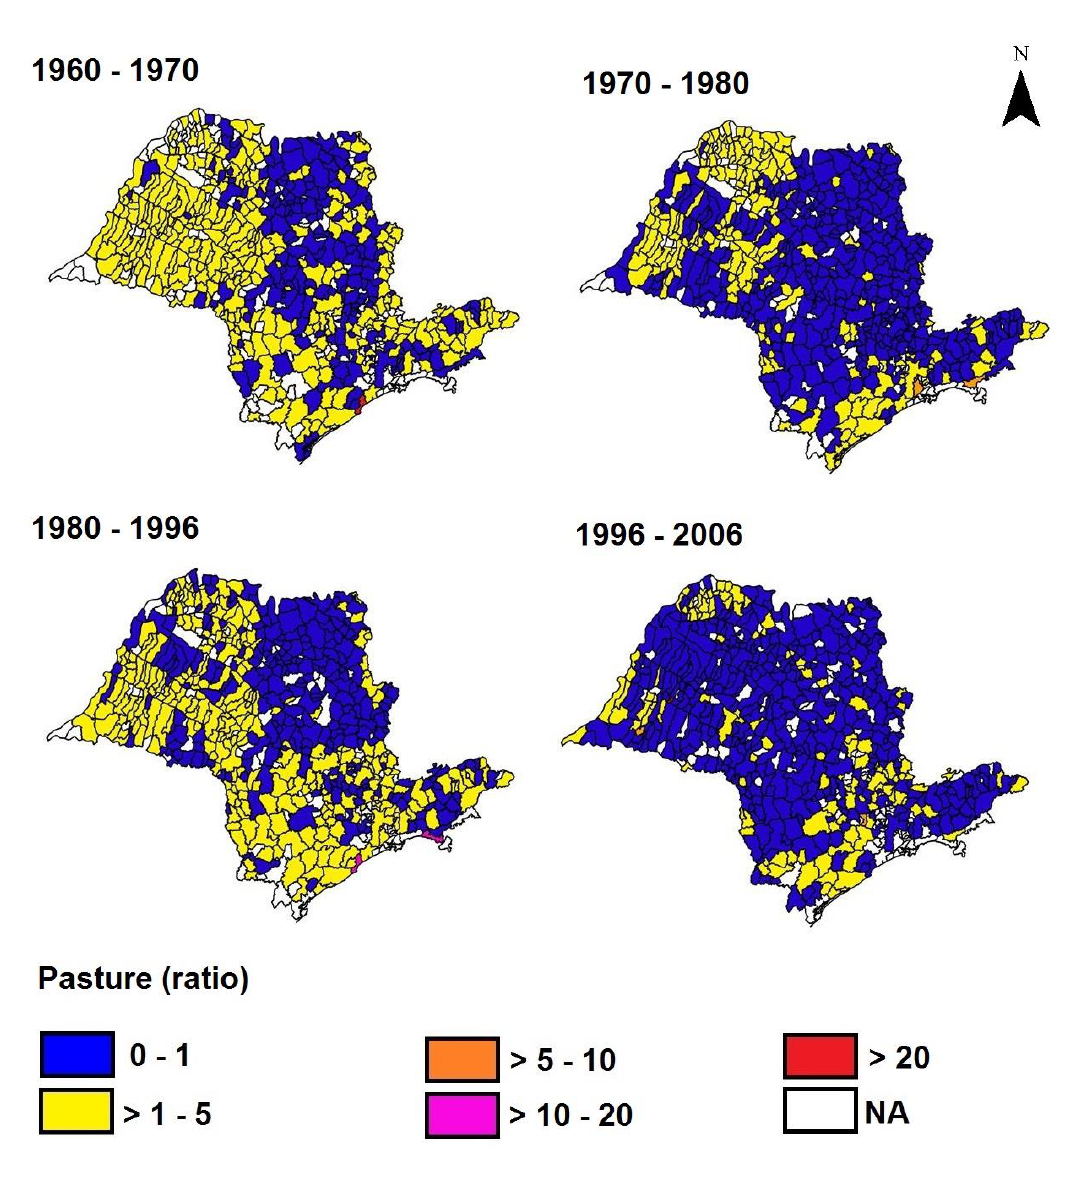
FIGURE A1.5 Pasture ratio at the municipality-scale for São Paulo state calculated for the intervals 1960-1970, 1970-1980, 1980-1996 and 1996-2006. Pasture ratio was calculated by dividing the pasture percentage in one census by pasture percentage in the previous census (e.g. values in 1970 / values in 1960). Ratio values greater than 1 (one) indicate that pasture increased over the census interval and values lower than 1 (one) indicate that it decreased. Municipality boundaries are shown in black. (NA) Missing